Question: What form of chart is displayed?
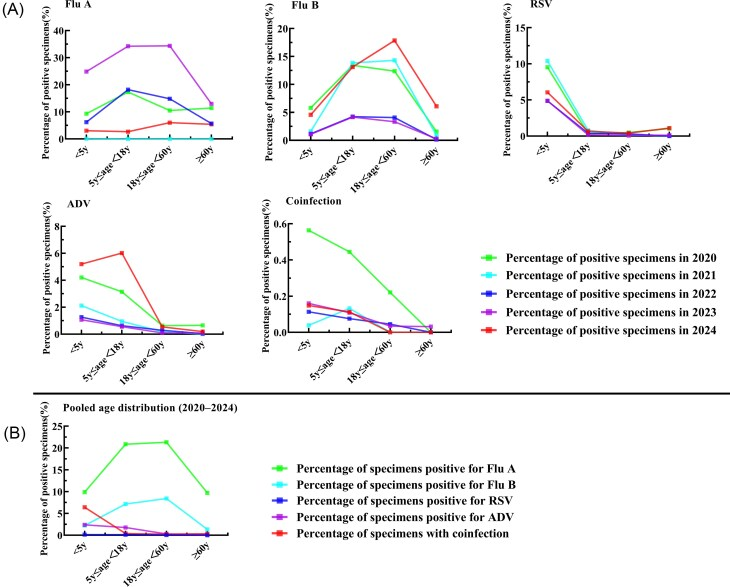
Answer: line